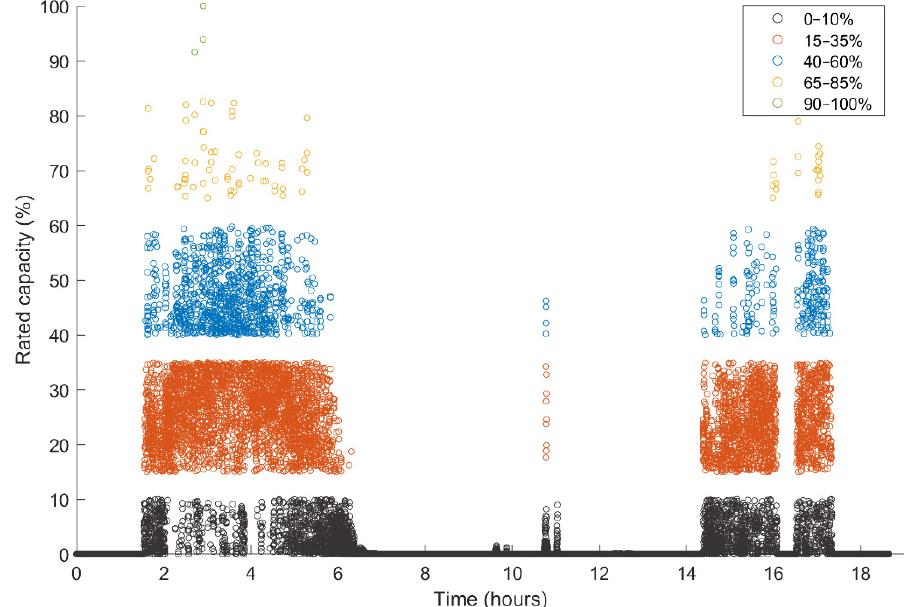
Figure 3. Turbine power-rated capacity at five color-coded ranges (0%, 25%, 50%, 75%, 100%, ± 10%), on 23 July 2021, from midnight to 18:39:14, Eastern Daylight Time (EDT). The rated capacity shown here was calculated by dividing the turbine power generation time series by the measured maximum turbine power output observed during the ~19-h period on 23 July 2021. Note, hydrophone recordings were limited to daylight hours during the second ebb tide period (13:54:00–17:16:00